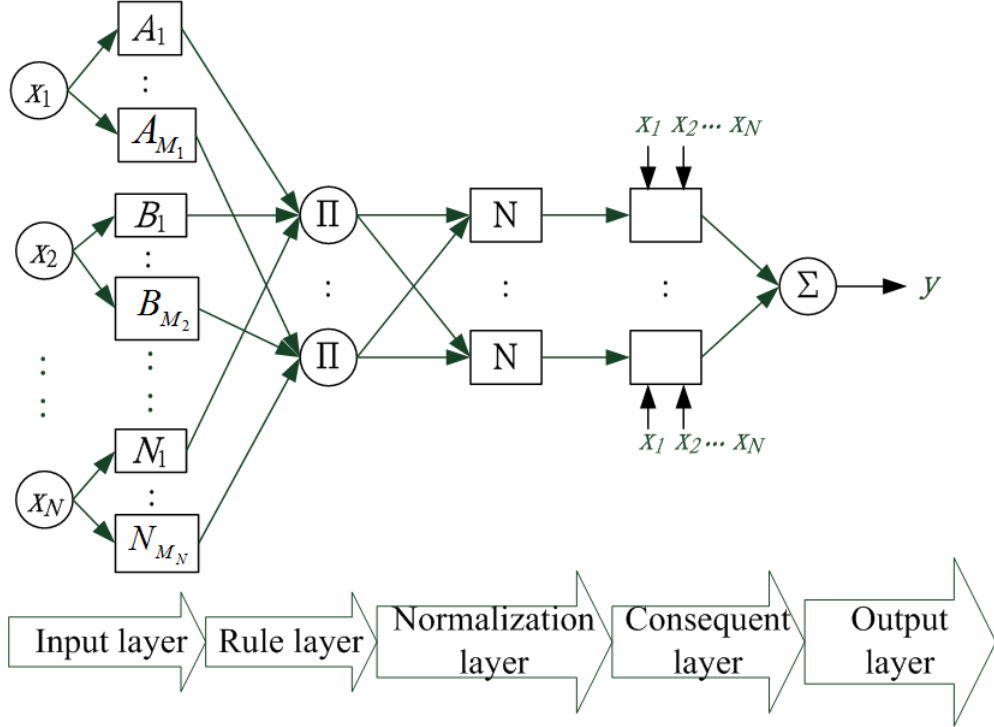
Figure 6. Structure of an